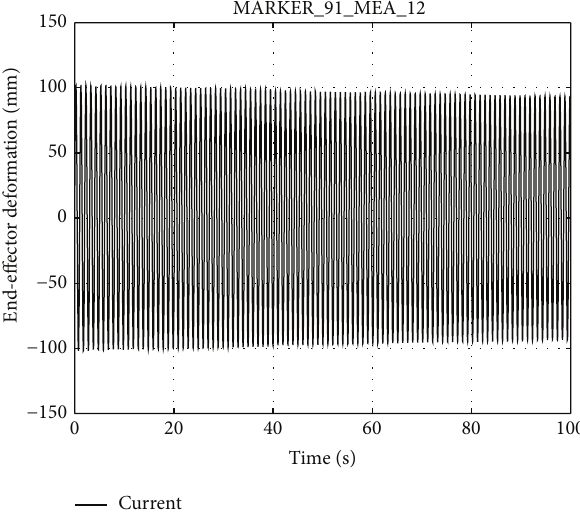
Figure 5: Undamped modal amplitudes in fixed flexible arm.